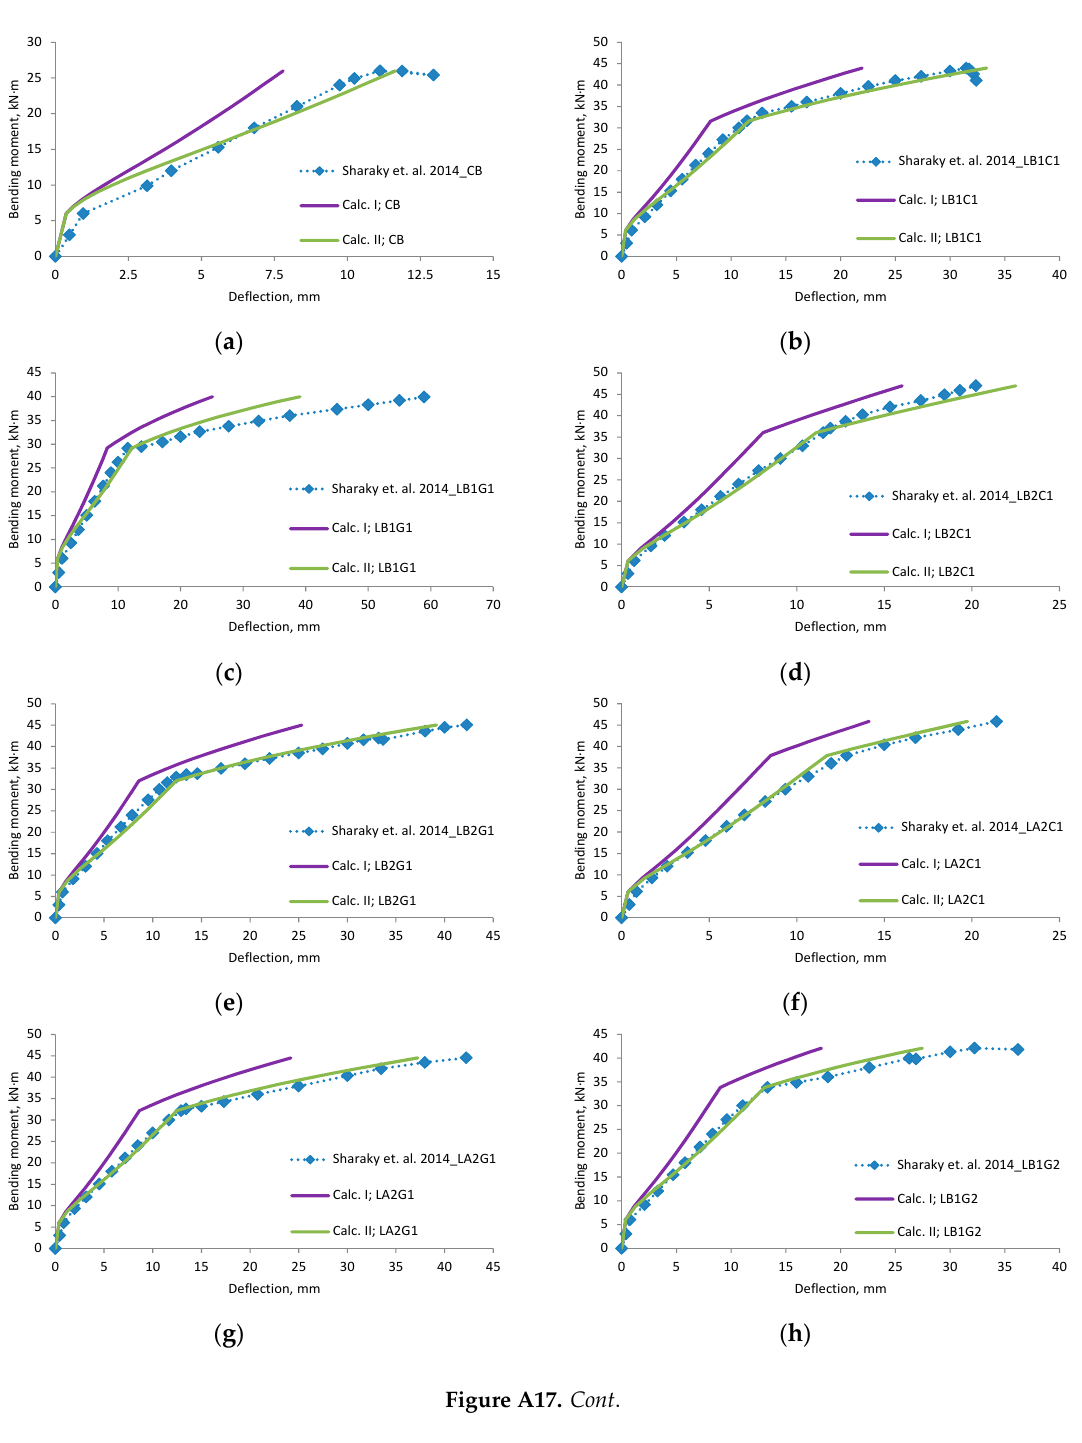
Figure A17. Cont